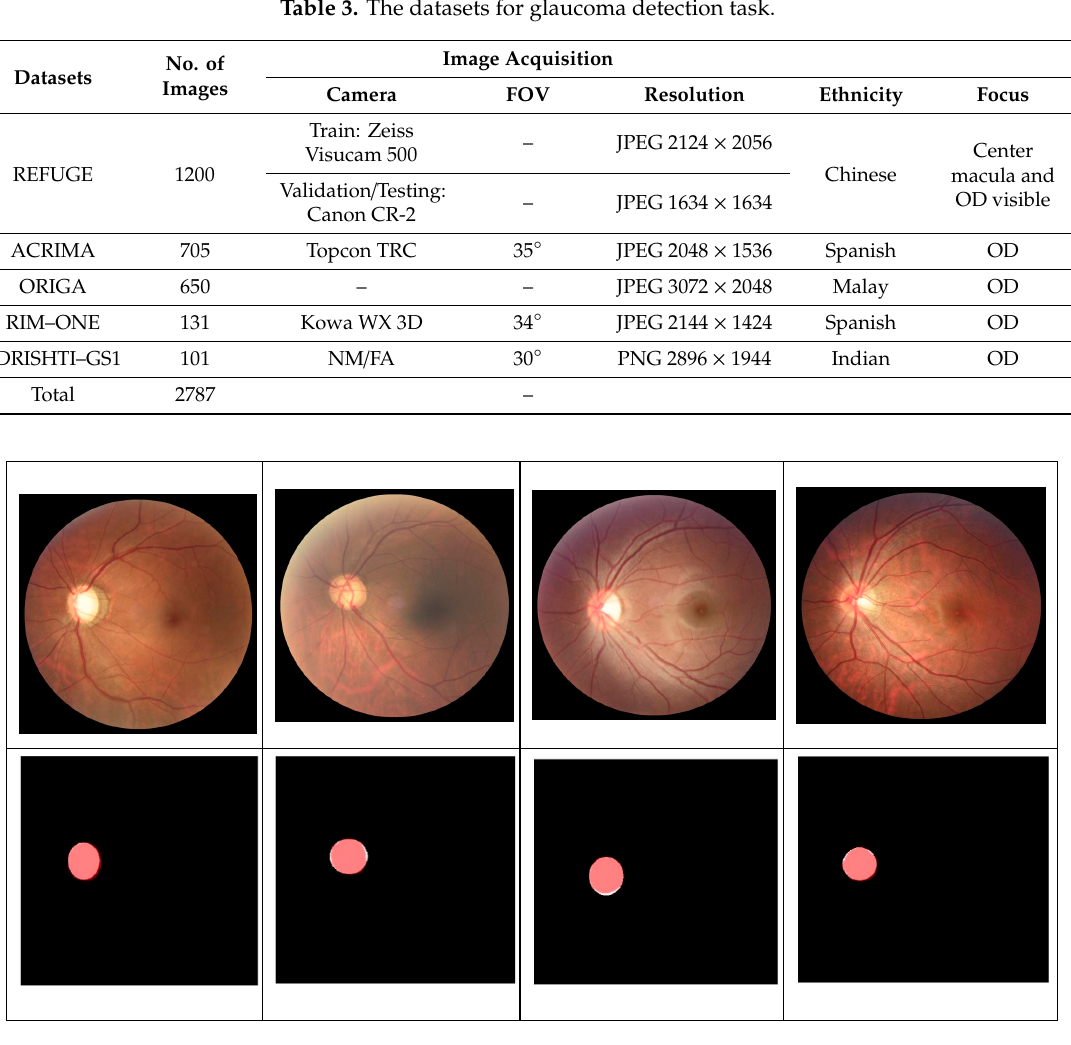
Figure 9. Pixel overlaps between our OD detection (pink masks) and the white ground truth mask.